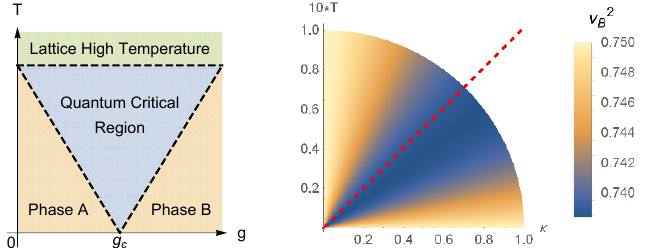
Figure 1 . Left: the schematic phase diagram of quantum phase transition. Right: density plot of butter(cid:13)y velocity v B in the phase diagram of AdS-AdS domain wall. The red dashed line mark the place where scalar (cid:12)eld at the horizon reaches half of its value at IR (cid:12)xed point. Such line indicate the vague boundary between quantum critical region and non-quantum-critical-region, namely T and j (cid:20) j z(cid:23) are comparable ( z(cid:23) in these two plots is equal to 1). One can compare these two plots by identifying (cid:20) (cid:24) g (cid:0) g c